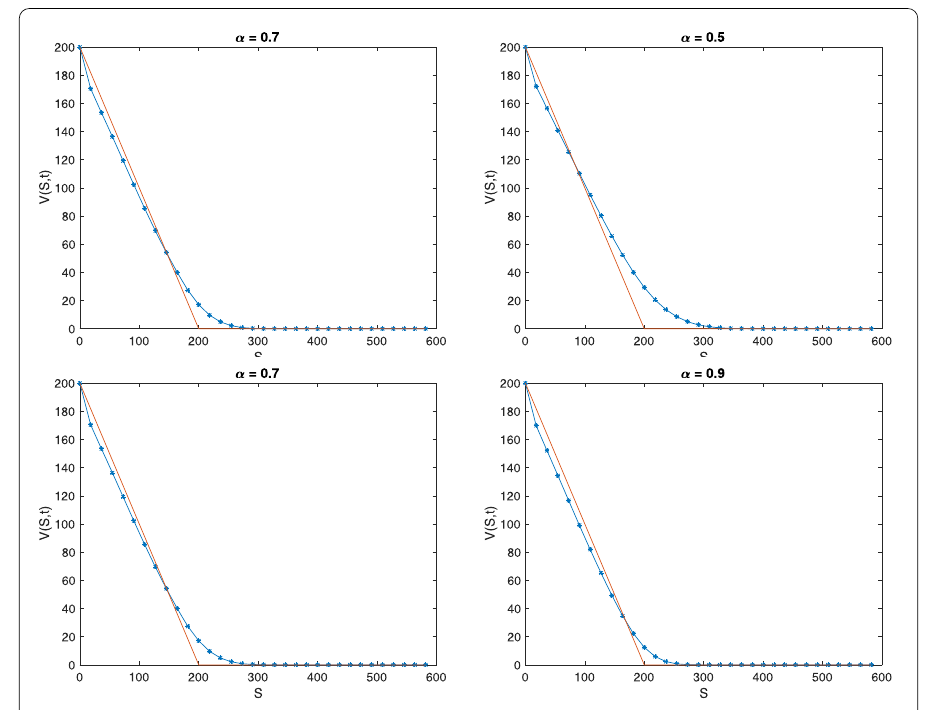
Figure 8 Payoffs under Example 5.2 for α = 0.3,0.5,0.7,0.9; δ = 0.085 at t = T